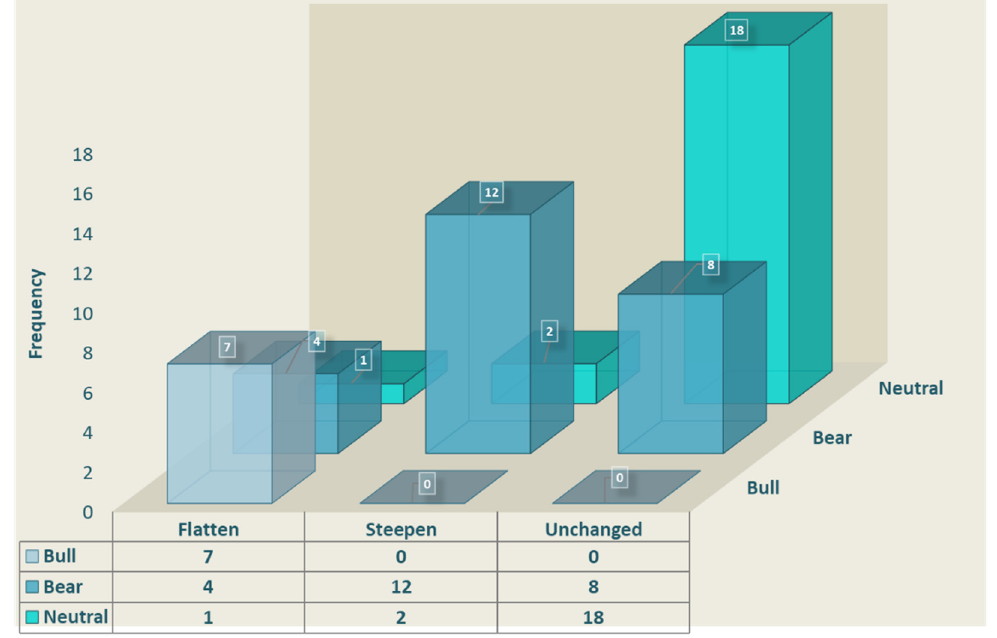
Figure A2. Weekly yield curve patterns at 25.03.2022 (last 52 weeks). Source: Bloomberg yields, own computation of yield curve patterns. Table A1. One-standard-deviation PCA annualized yield curve shocks and corresponding explan- atory powers on 25 March 2022.